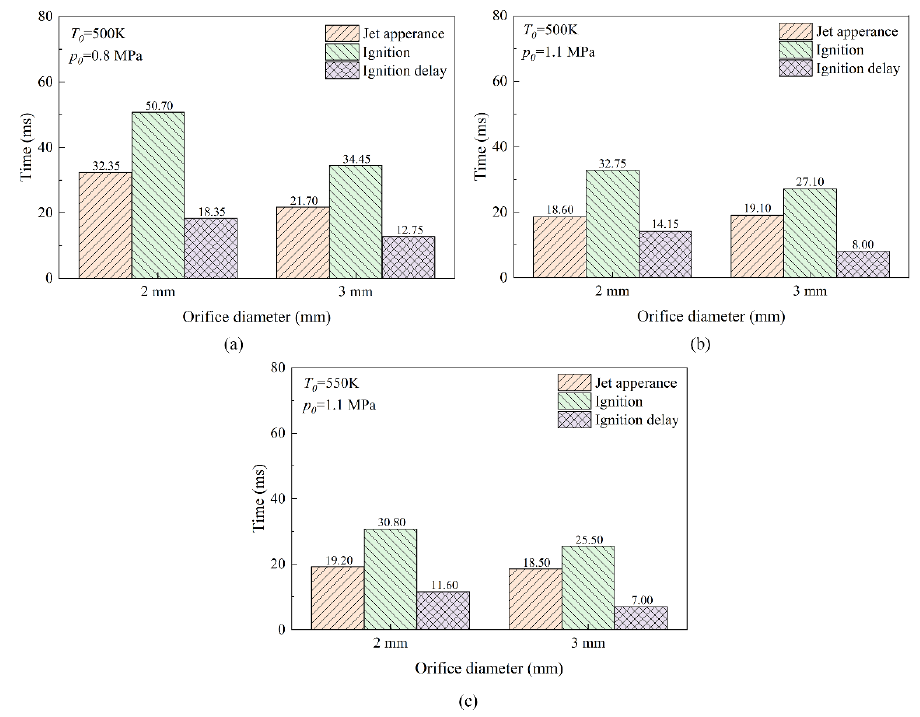
Figure 14. Jet appearance and ignition timings in the main chamber and ignition delays for different pre-chamber orifice diameters under different initial thermodynamic parameters. pre-chamber orifice diameters under different initial thermodynamic